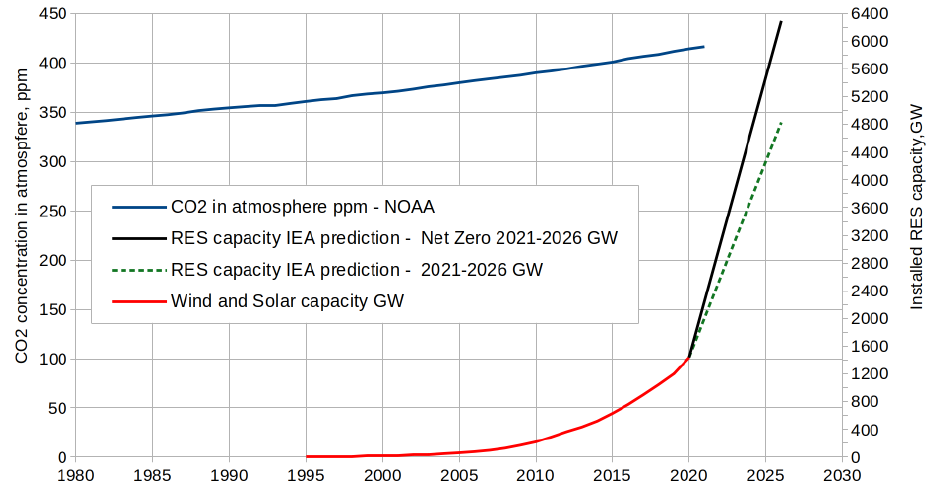
Figure 1. Comparison of the increase in CO 2 concentration in the atmosphere (Mauna Loa Observa- tory, Waimea, HI, USA) with the increase in installed RES capacity around the world,